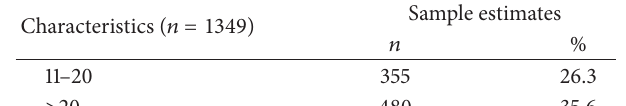
Table 1: Characteristics of female sex workers of reproductive age in key populations studies in Togo and Burkina